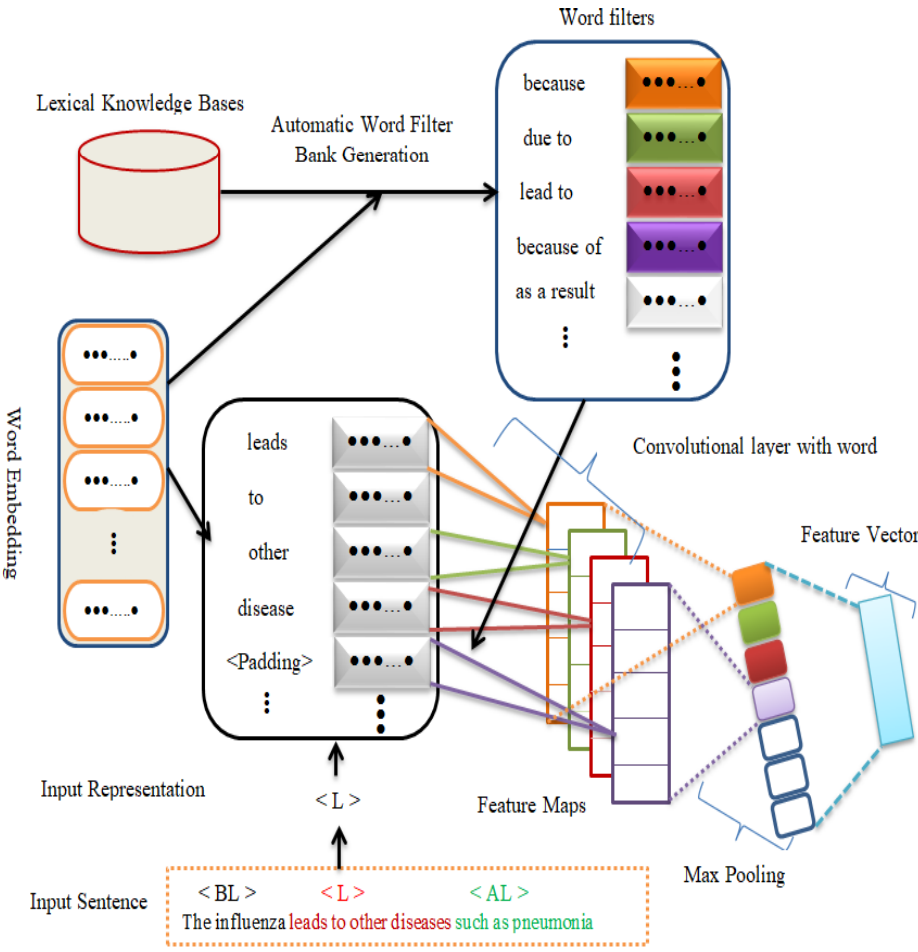
Figure 3. Knowledge-oriented channel for connective part of the input sentence.